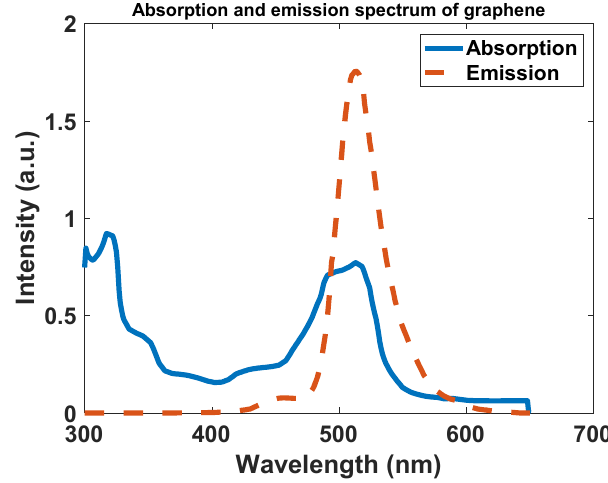
Figure 6. Absorption and emission spectrum of graphene.